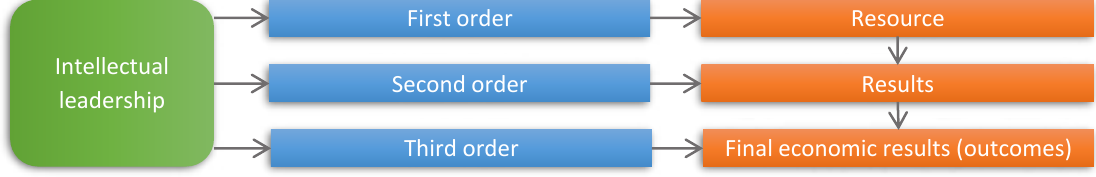
Figure 1. Levels of the implementation of intellectual leadership (compiled by the authors)